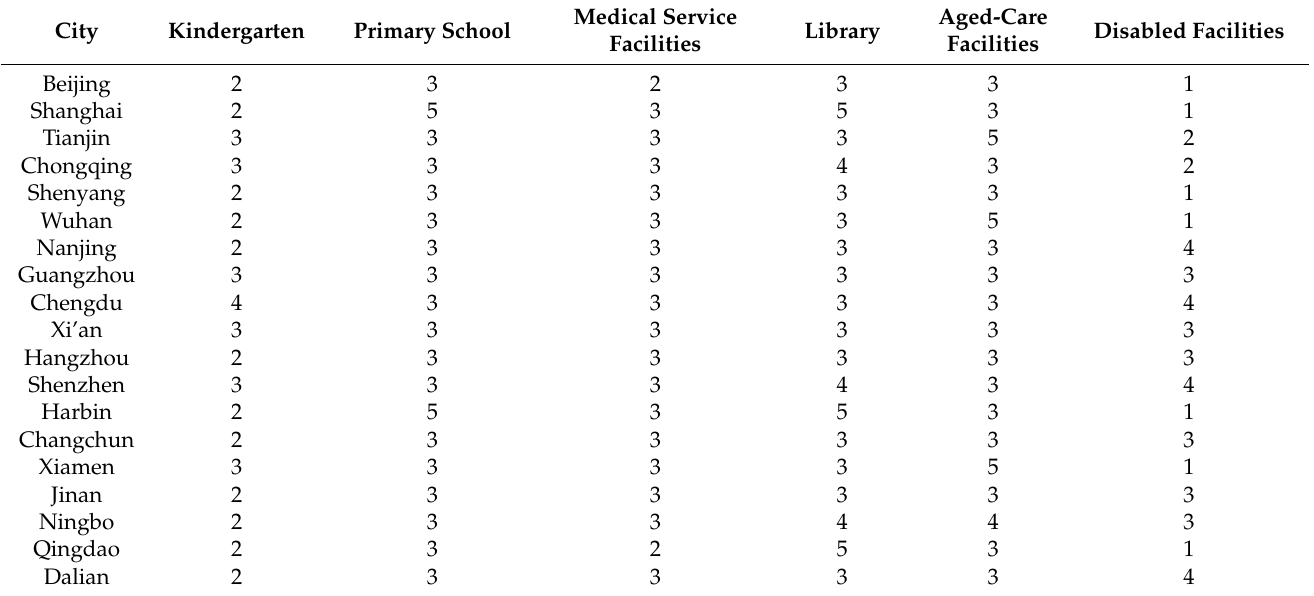
Table 3. Classification results of typical human settlement spatial distribution